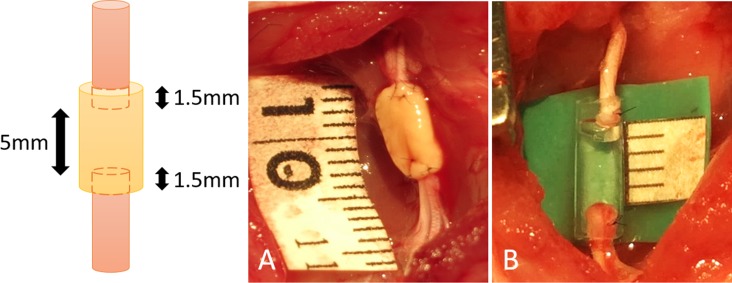
A: In the Bio 3D group, an 8-mm Bio 3D conduit was interposed into the nerve defect, and the proximal and distal nerve stumps were secured 1.5 mm into the tube to create a 5-mm interstump gap in the conduit. B: In the silicone group, the silicone tube with 8 mm length was interposed in the same procedure.